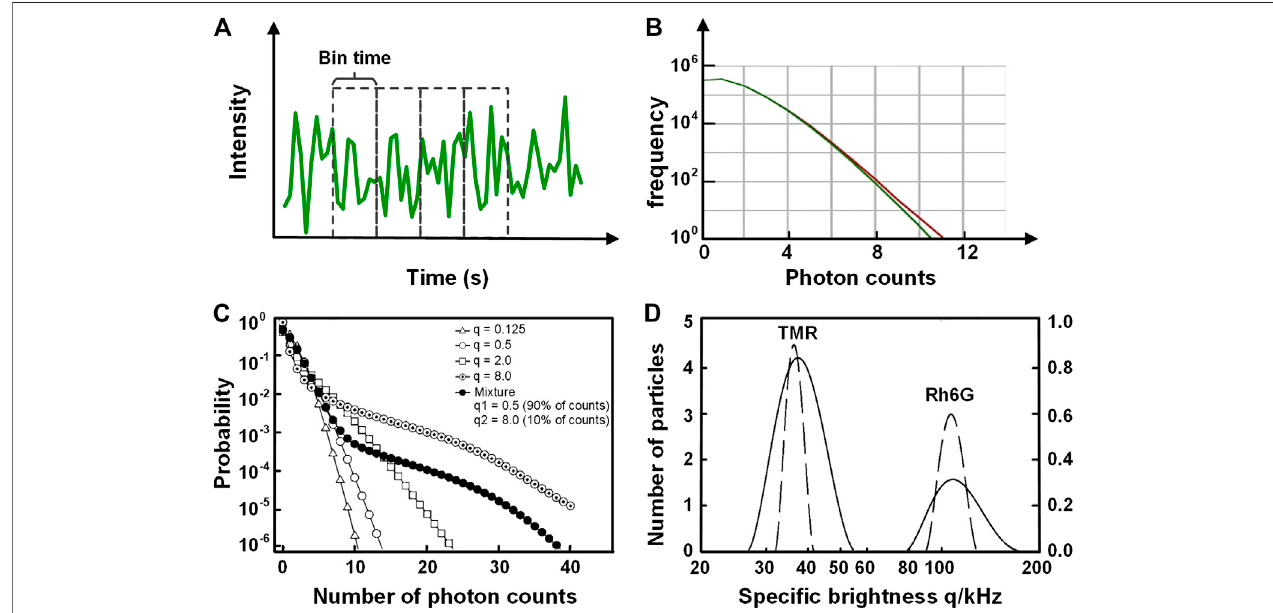
FIGURE11| SchematicillustrationoftheprincipleofPCHandFIDA.( A )TheintensitytraceusedforPCH,whichisdividedintomultipleequivalenttimebins.( B )The statistics of the photon number per bin (red) for YFP-tagged beta2-adrenergic proteins within the plasma membrane of HEK293 cells. The histogram (red) is fi tted with the PCH model (green). The molecular brightness and the average number of molecules can be acquired from the fi tting result. Adapted from [106]. ( C ) and ( D ) FIDA analysisonthedyesRh6GandTMRdiffusinginsolution( C )Theprobabilitydistributionfor fi vecasesfeaturingdifferentmeancountnumber q perparticle.Theopen symbols correspond to solutions of single species. The solid line is calculated for a mixture of two species. ( D ) The brightness histogram of different species obtained from ( C ) with the inverse transformation with regularization (ITR). The dashed lines correspond to the solutions of single dyes (Rh6G and TMR), and the solid line corresponds to their mixture. Adapted from